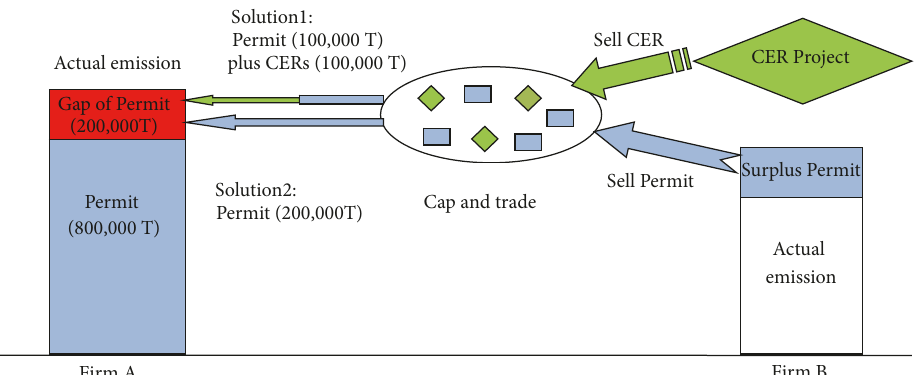
Figure 1: The compliance program of firm